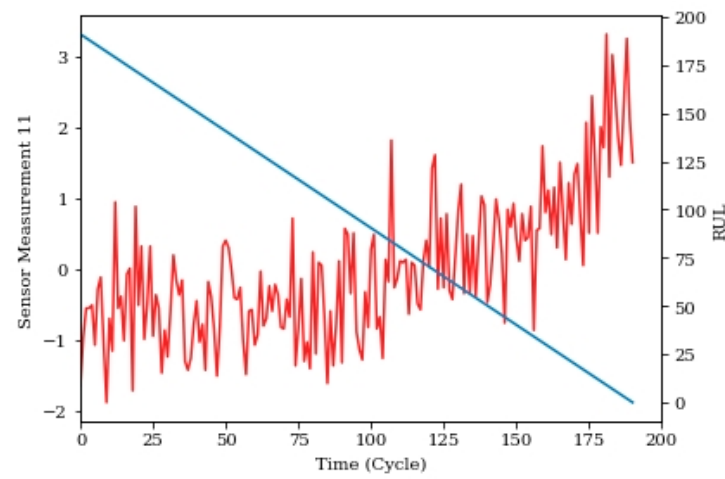
Figure 8. CMAPSS Sensor measurement 11 and remaining useful life (RUL) versus cycle.